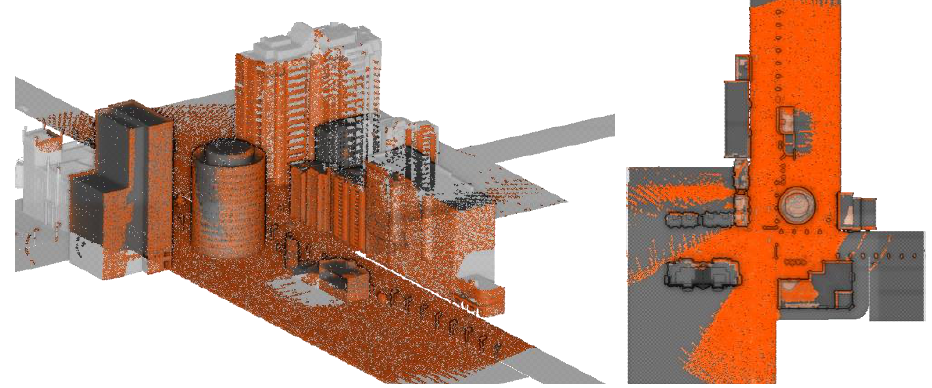
Figure 15. Illustration of point cloud coverage amount with respect to the reference model.